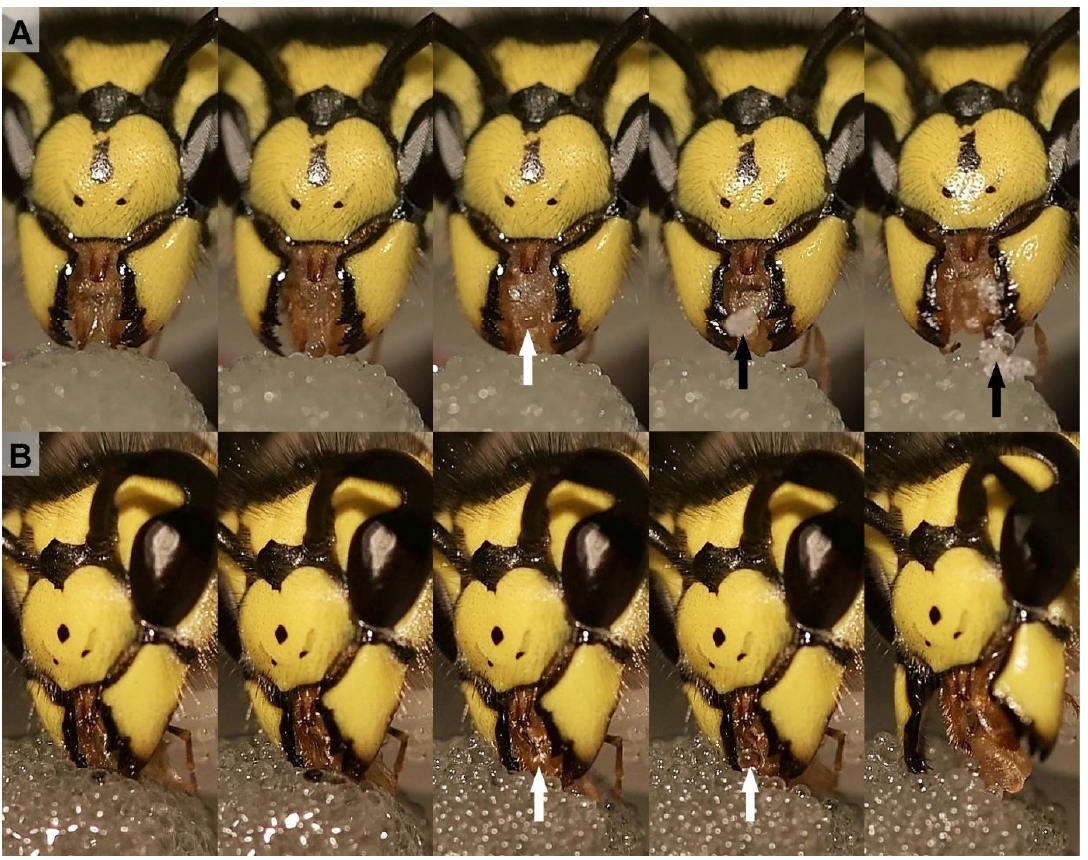
Figure 2. Feeding experiment using glass beads in sugar water with Vespula germanica; single frames from the video footage; ( A ) Uptake of the sugar water with the glass beads (<152 – 600 µm). ( B ) Uptake of the sugar water only with bigger particles (212 – 300 µm). The bigger glass beads were prevented from entering the wasp proboscis (white arrow). The small glass beads entered between the mouthparts (black arrow); some were filtered out and ejected after the liquid ingestion.